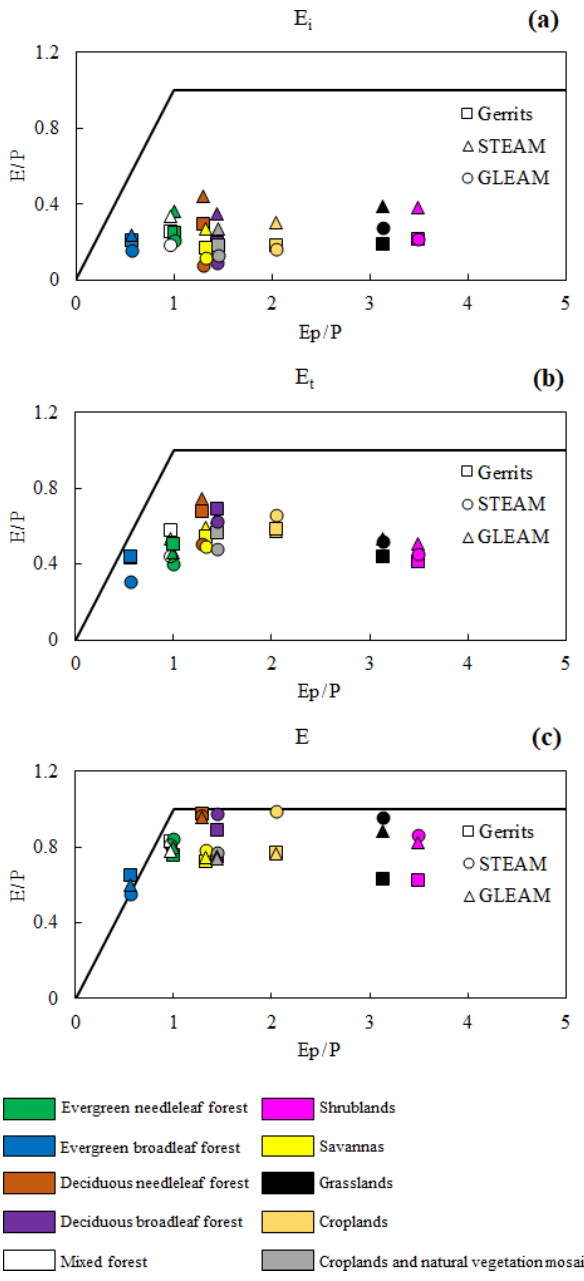
Figure 8. Comparison of interception (a) , transpiration (b) , and to- tal evaporation (c) among models for each land cover within the Budyko framework.